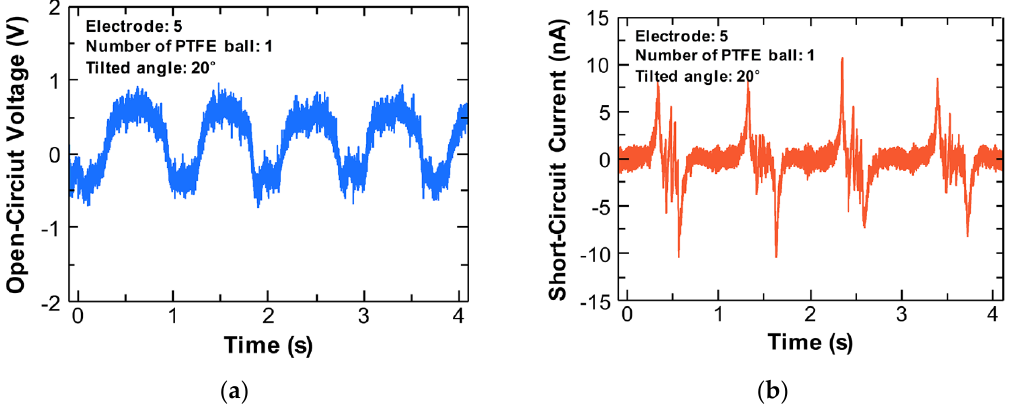
Figure 2. Electrical signals of a polytetrafluoroethylene (PTFE) ball from one Al electrode: ( a ) Open-circuit voltage. ( b ) Short-circuit current.